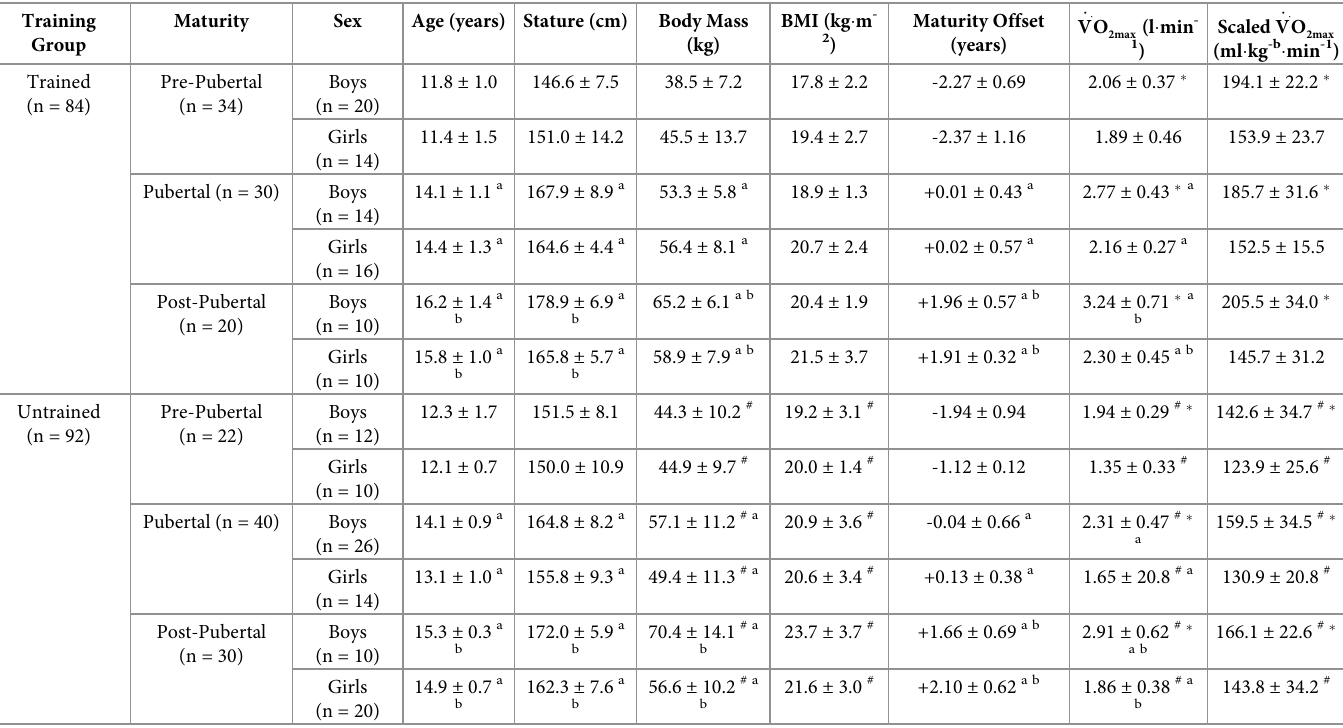
Table 1. Participant